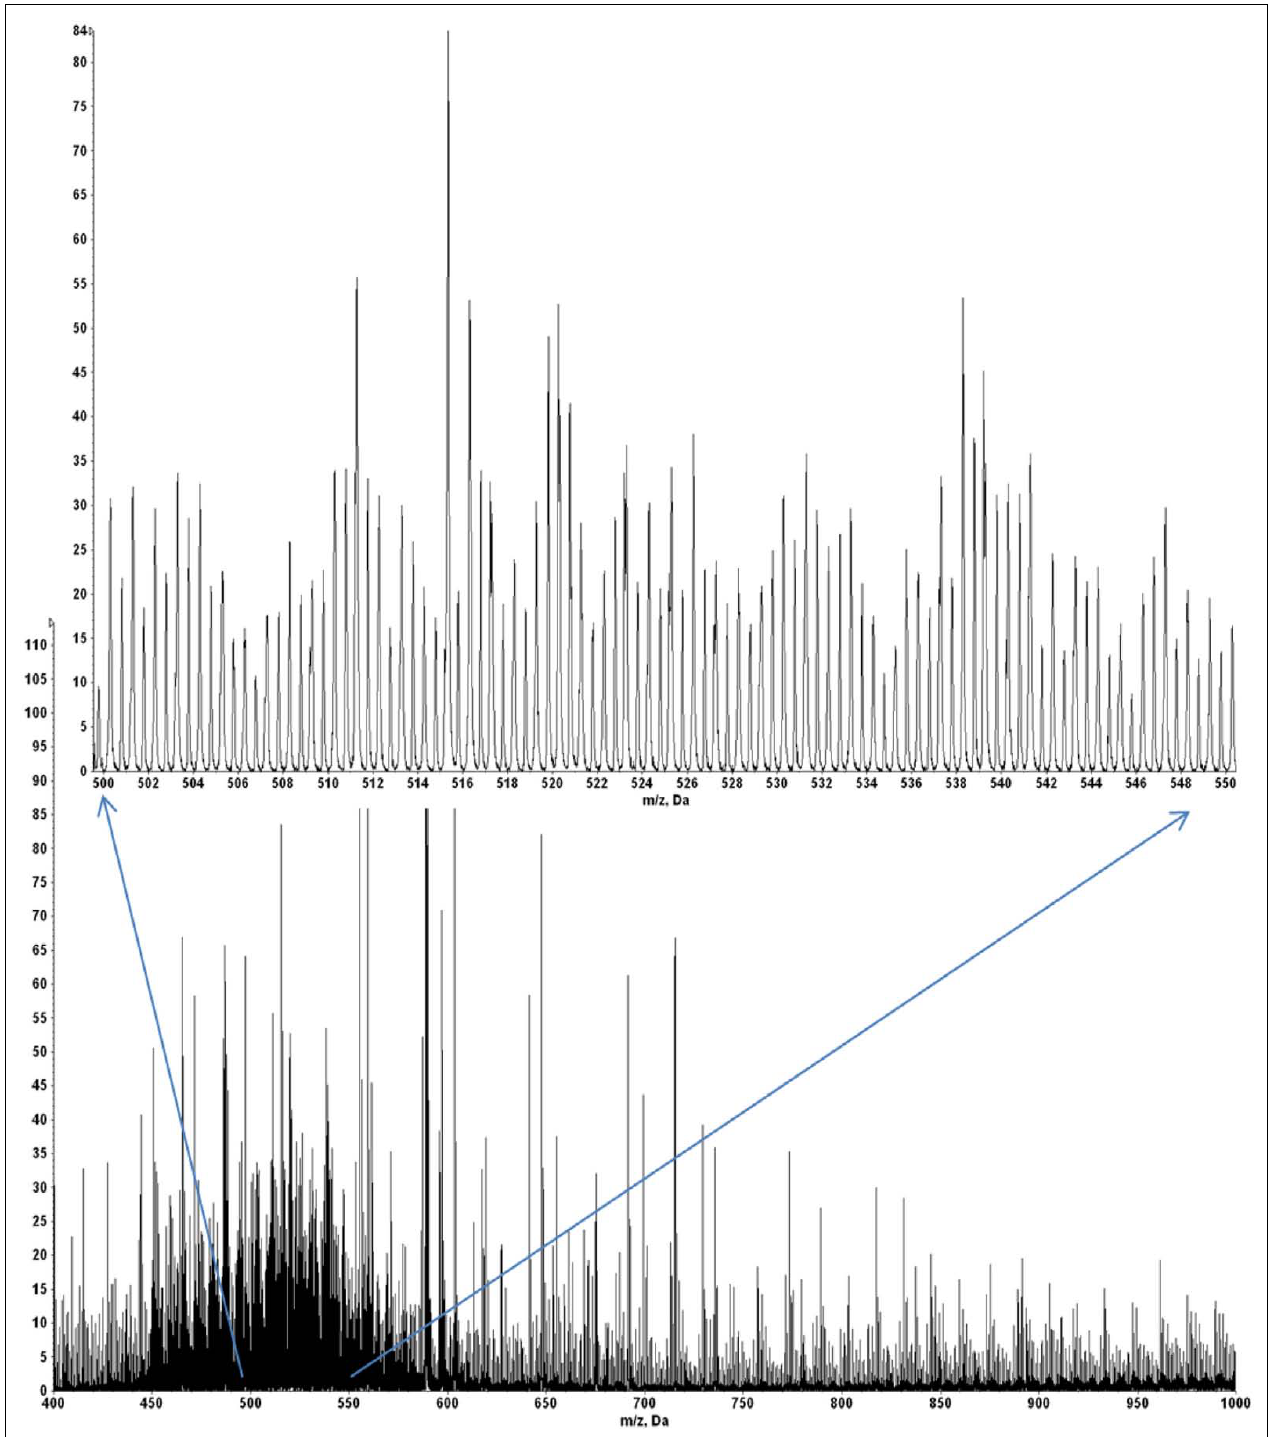
FIGUREA9 |The mass spectrum of HLA-A2 bound peptides from tumor sample KTS5. Doubly charged peptides from m / z 450 to 600 (inset) provide a “hump” that roughly characterizes the overall recovery.